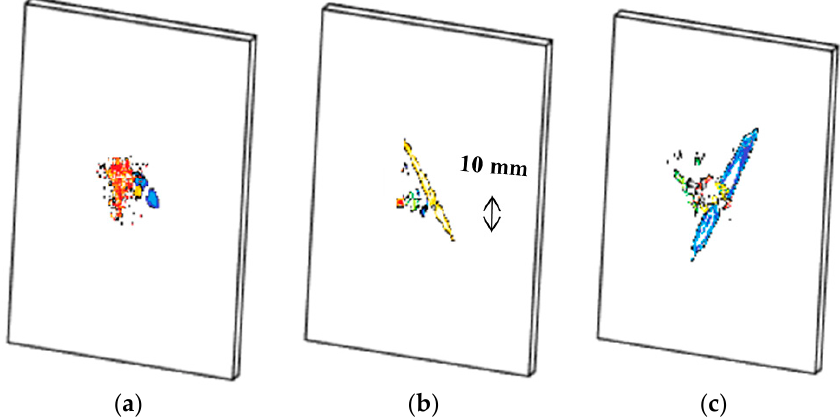
Figure 8. Reconstruction of impact damage in 5 mm-thick CFRP composite by using time-domain thermal tomograms from Figures 5–7: ( a ) impact energy 10 J, ( b ) 18 J, ( c ) 63 J.